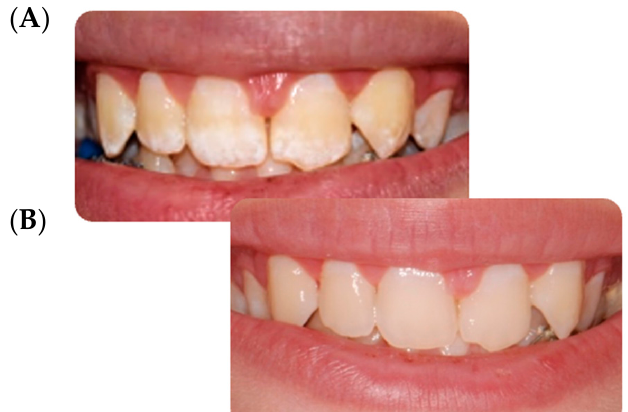
Figure 2. Fluorosis. ( A ) Opacities on all upper teeth especially located on the incisal and cervical tooth’s buccal surfaces. ( B ) 24-month follow up.